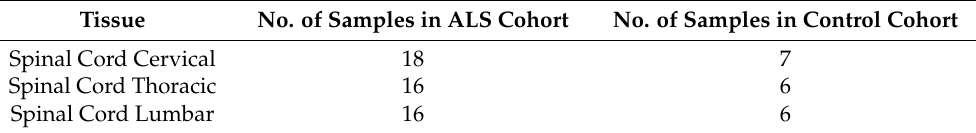
Table 4. Number of spinal cord biological samples utilized in ALS and control conditions. Tissue No. of Samples in ALS Cohort No. of Samples in Control Cohort Spinal Cord Cervical Spinal Cord Thoracic Spinal Cord